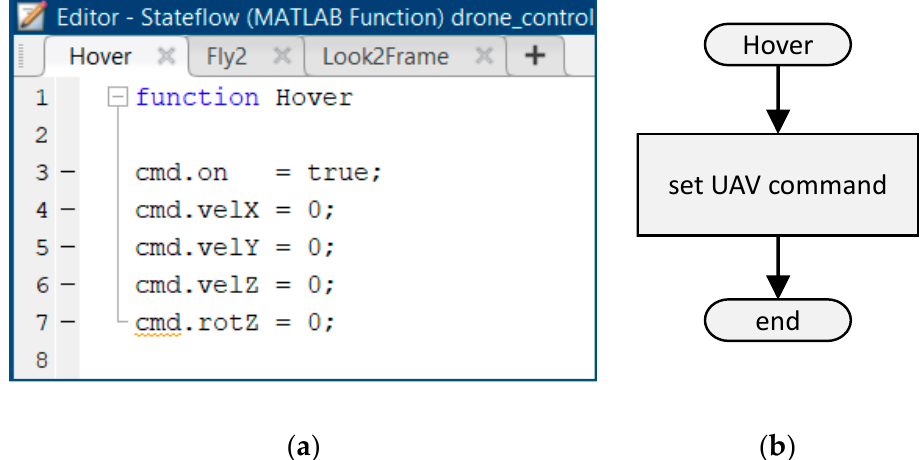
Figure 9. Hover MATLAB function defined in Figure 7: ( a ) implementation; ( b ) flow chart. After the activation of the motors, the state machine switches directly to the SetBase state. The purpose of this state is to assign the initial drone position since this will also be its return position after completing its mission. As shown in Figure 3, the autopilot Stateflow block receives the current drone position through the imu input bus, which has no valid information until the second execution of the state machine. Therefore, this assignment cannot be made in the Start state, which explains the existence of this second